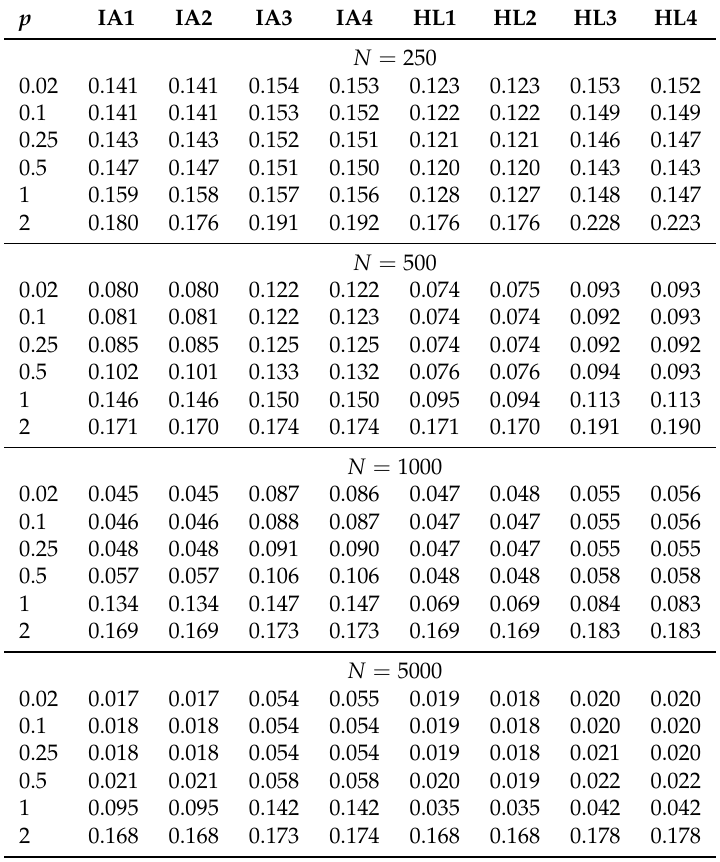
Table 5. Simulation Study 2: Average Root Mean Square Error (ARMSE) of Group Means as a Function of Sample Size in the Condition of Differential Item Functioning (DIF) and G = 18